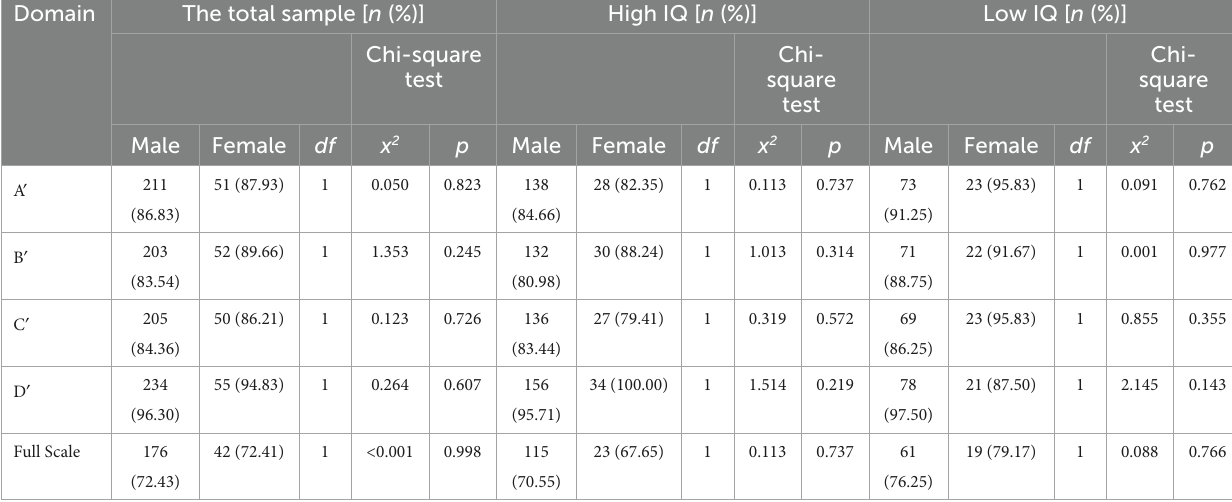
TABLE 3 Comparisons of the autism diagnosis compliance rate in the subdomains of ADI-R between males and females with ASD.